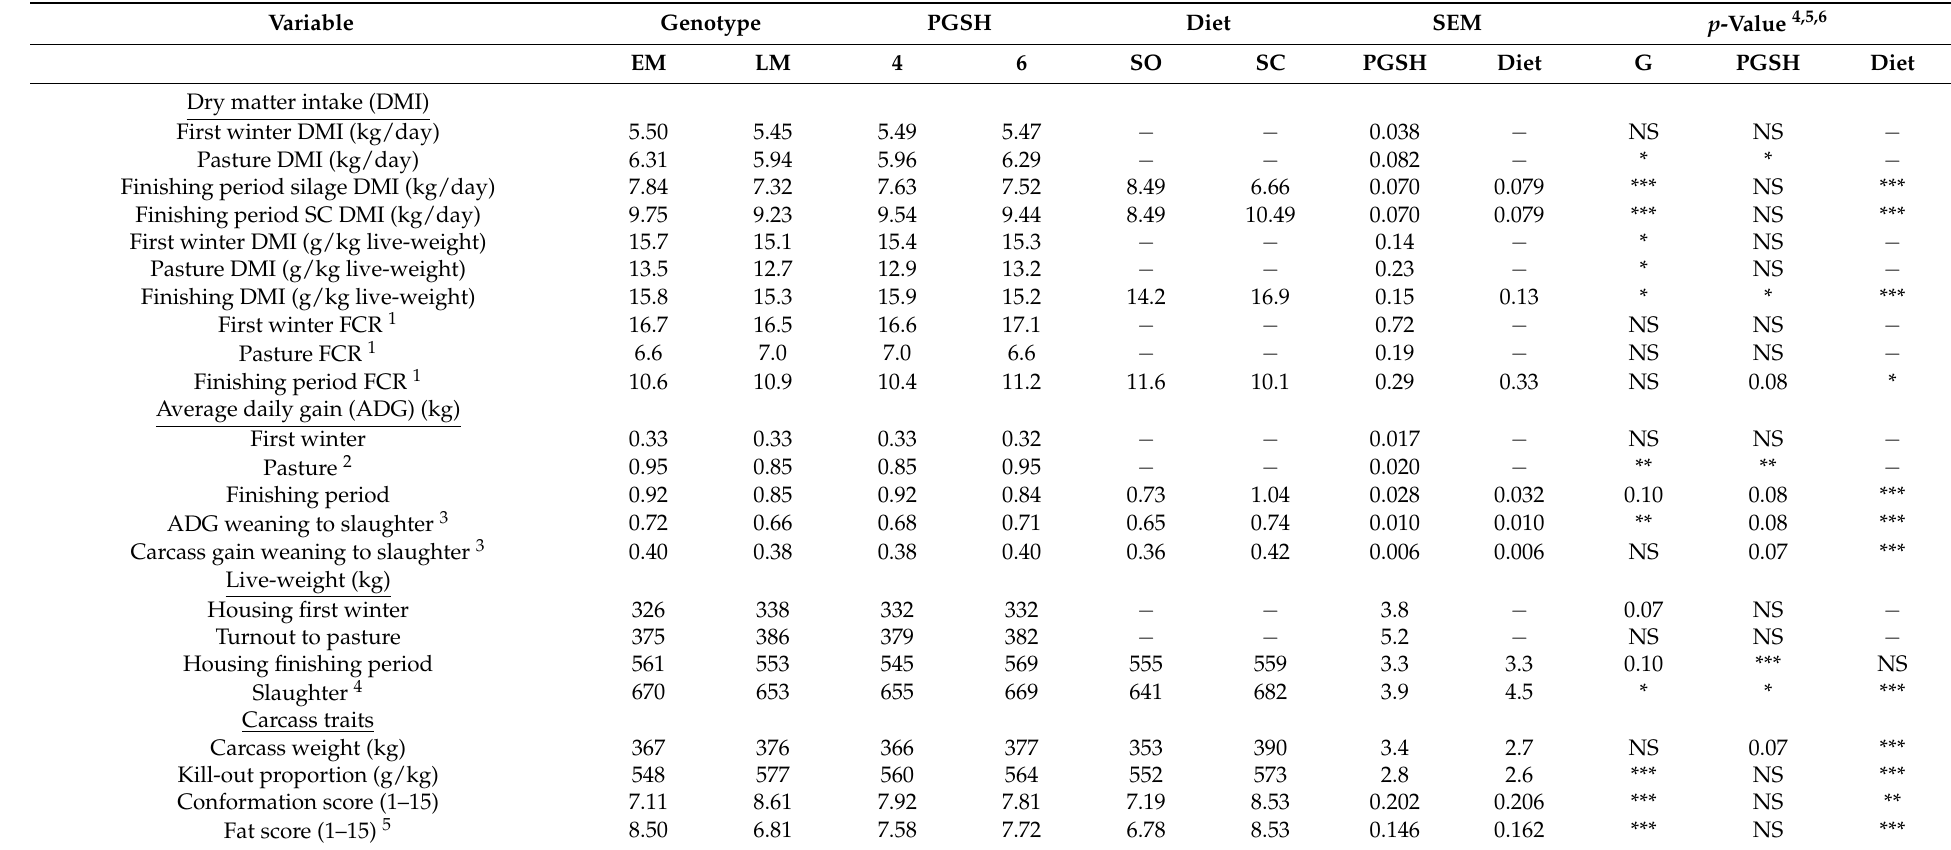
Table 5. The effects of genotype (G-early- (EM) or late-maturing (LM)), post-grazing sward height (PGSH-4 or 6 cm) and finishing diet (Diet-grass silage only (SO) or grass silage supplemented with 3.8 kg concentrate dry matter (SC)) on performance and carcass traits of suckler-bred steers during the first winter, grazing season and finishing